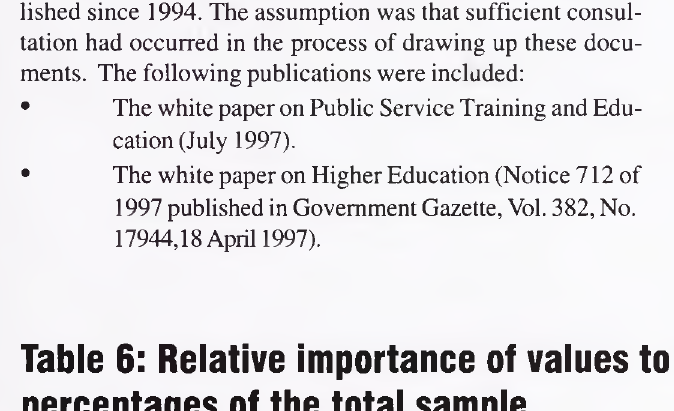
Stud Lect. Admin. Manag Staff